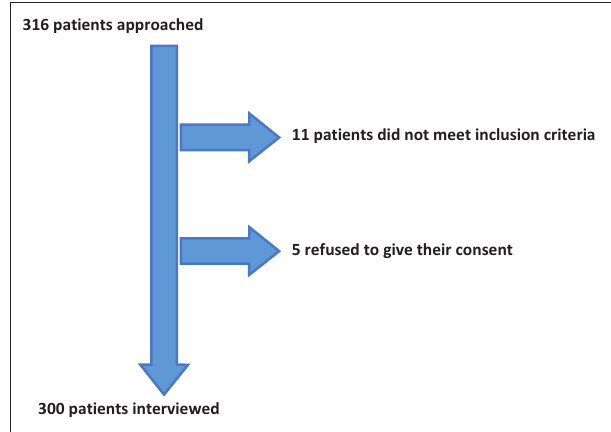
316 patients approached